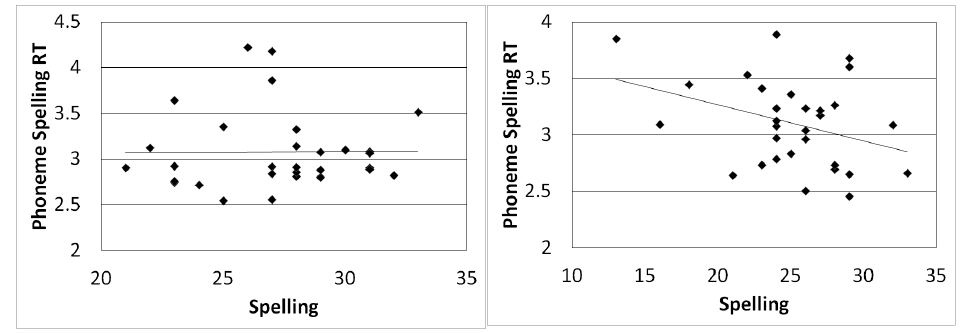
Figure 4. Correlation between phoneme spelling RT and spelling ability among nonphonological spellers, r (29)= .009, p = .960 (left), compared with correlation between phoneme spelling RT and spelling ability among phonological spellers, r (28)= 2 .353, p = .056 two-tailed and .028 one-tailed (right).